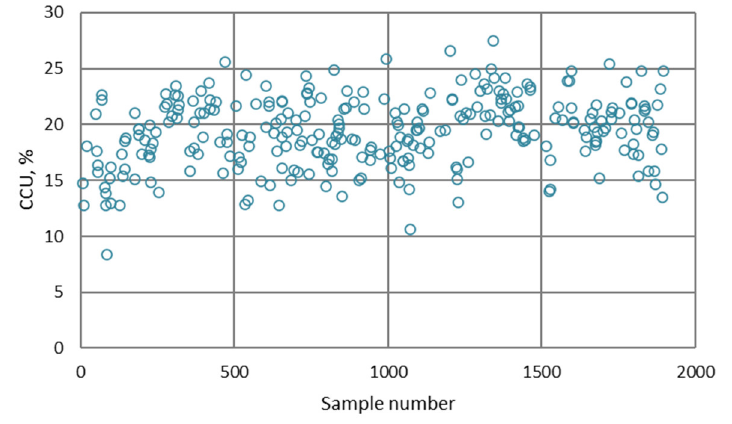
Figure A30. NN1 model—validation dataset.